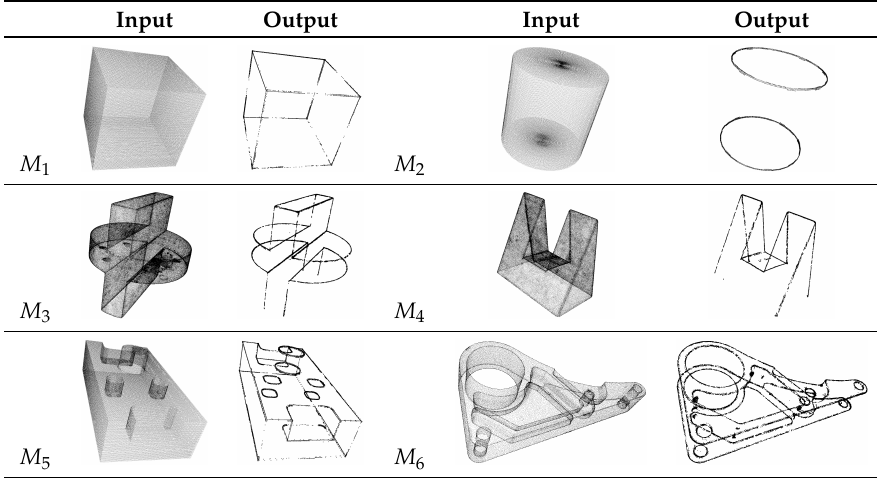
Table 2. The final segmentation using the initial value θ opt = 3.86.